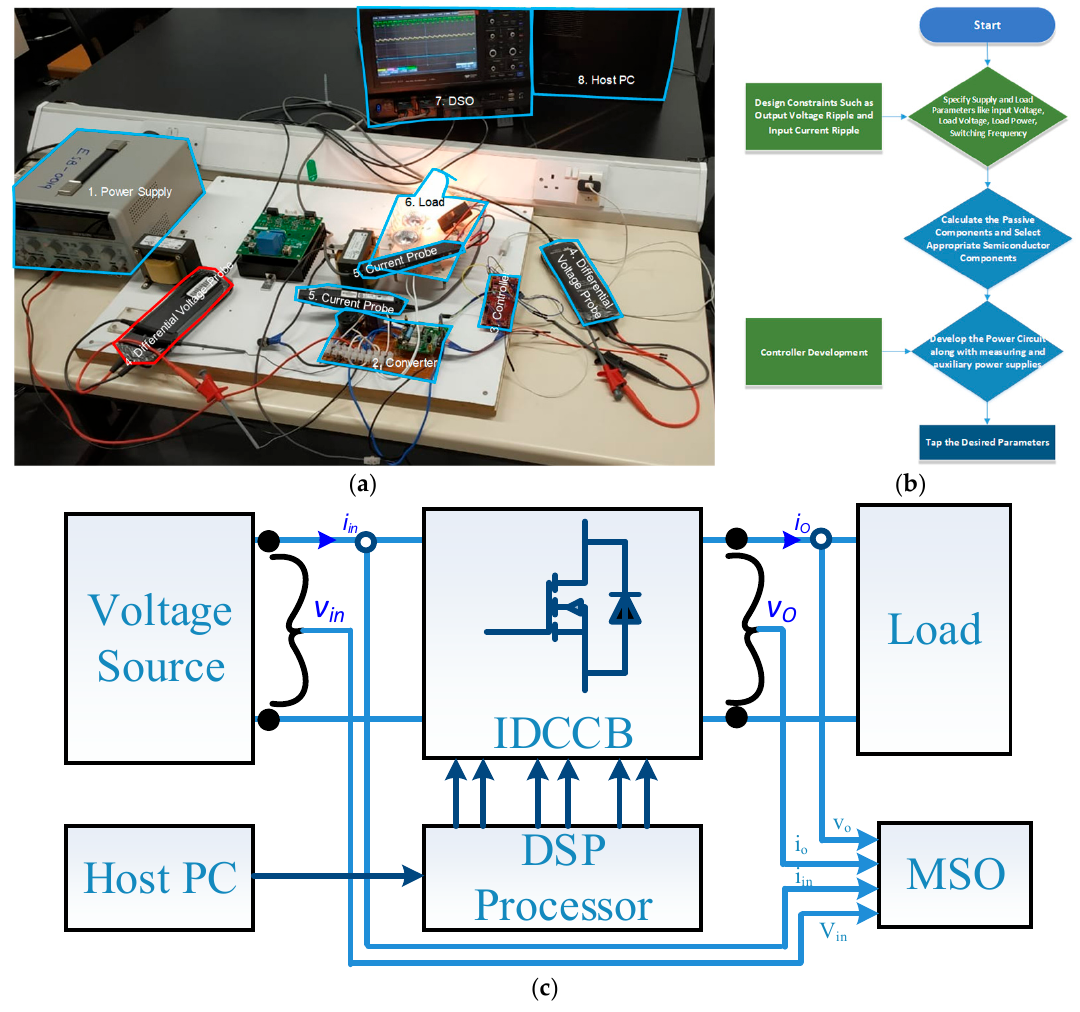
Figure 10. ( a ) Experimental setup: (1) power supply; (2) IDCCB converter; (3) DSP controller; (4) voltage probes; (5) current probes; (7) digital storage oscilloscope; (8) host PC. ( b ) Design guidelines flowchart for the IDCCB and ( c ) block diagram of the hardware setup.